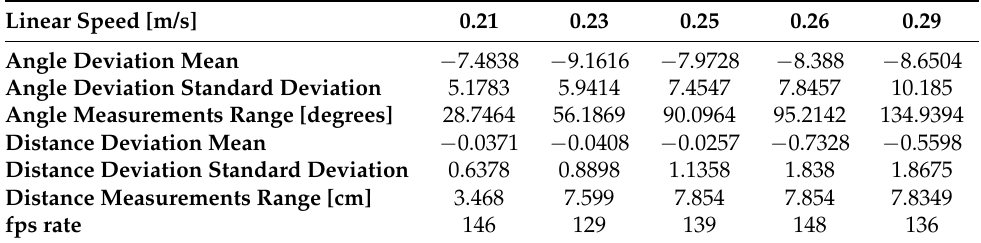
Table 9. Linear speed variation results summary with a 160 × 120 pixels image resolution, and a 30 × 10 pixels size rectangular kernel. Speed values greater than 0.21